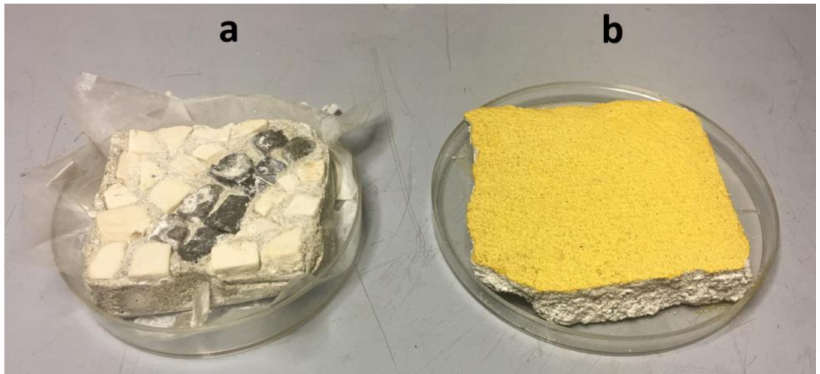
Figure 20. A mosaic floor ( a ) and fresco wall painting ( b ) mock-ups used for testing the THz imaging